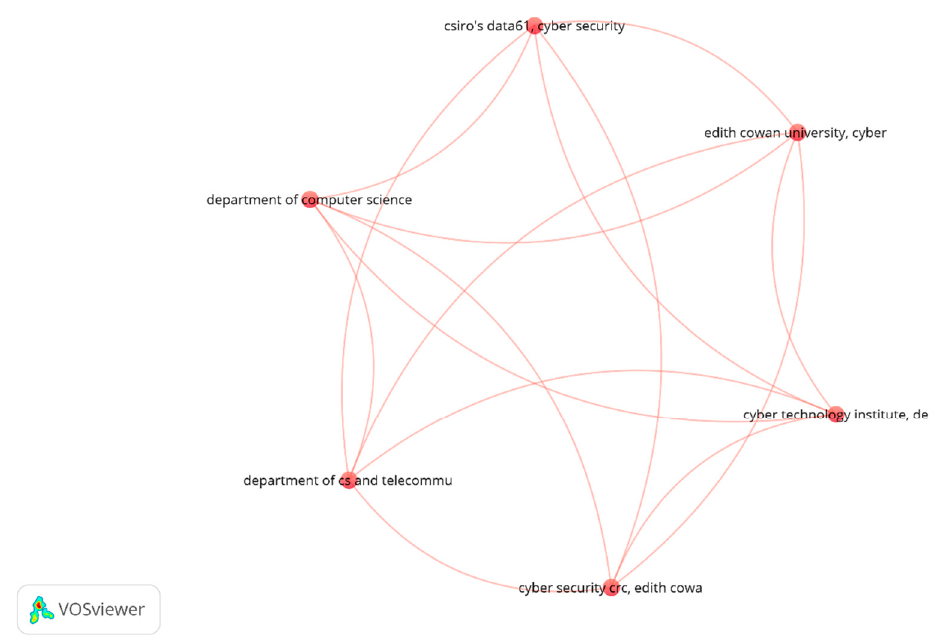
Figure 3. Cross-institutional collaborations in DT research in the CI.